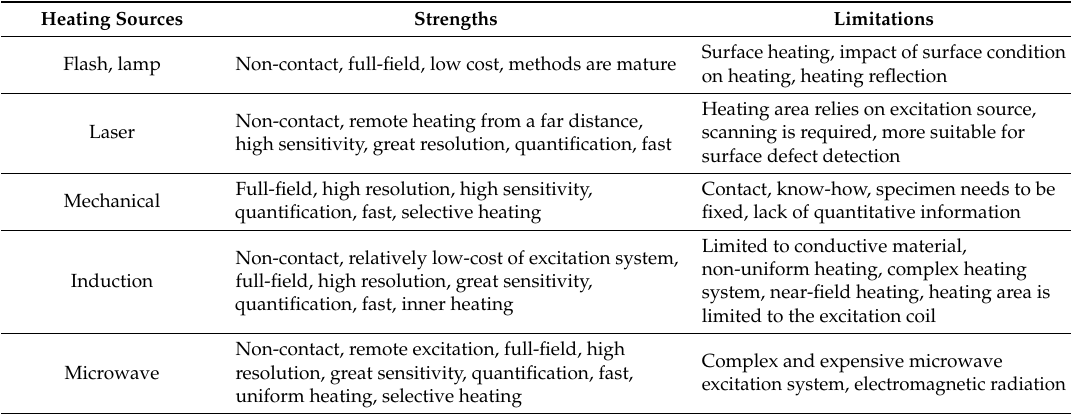
Table 3. Comparison of thermography inspection methods with different excitation sources.